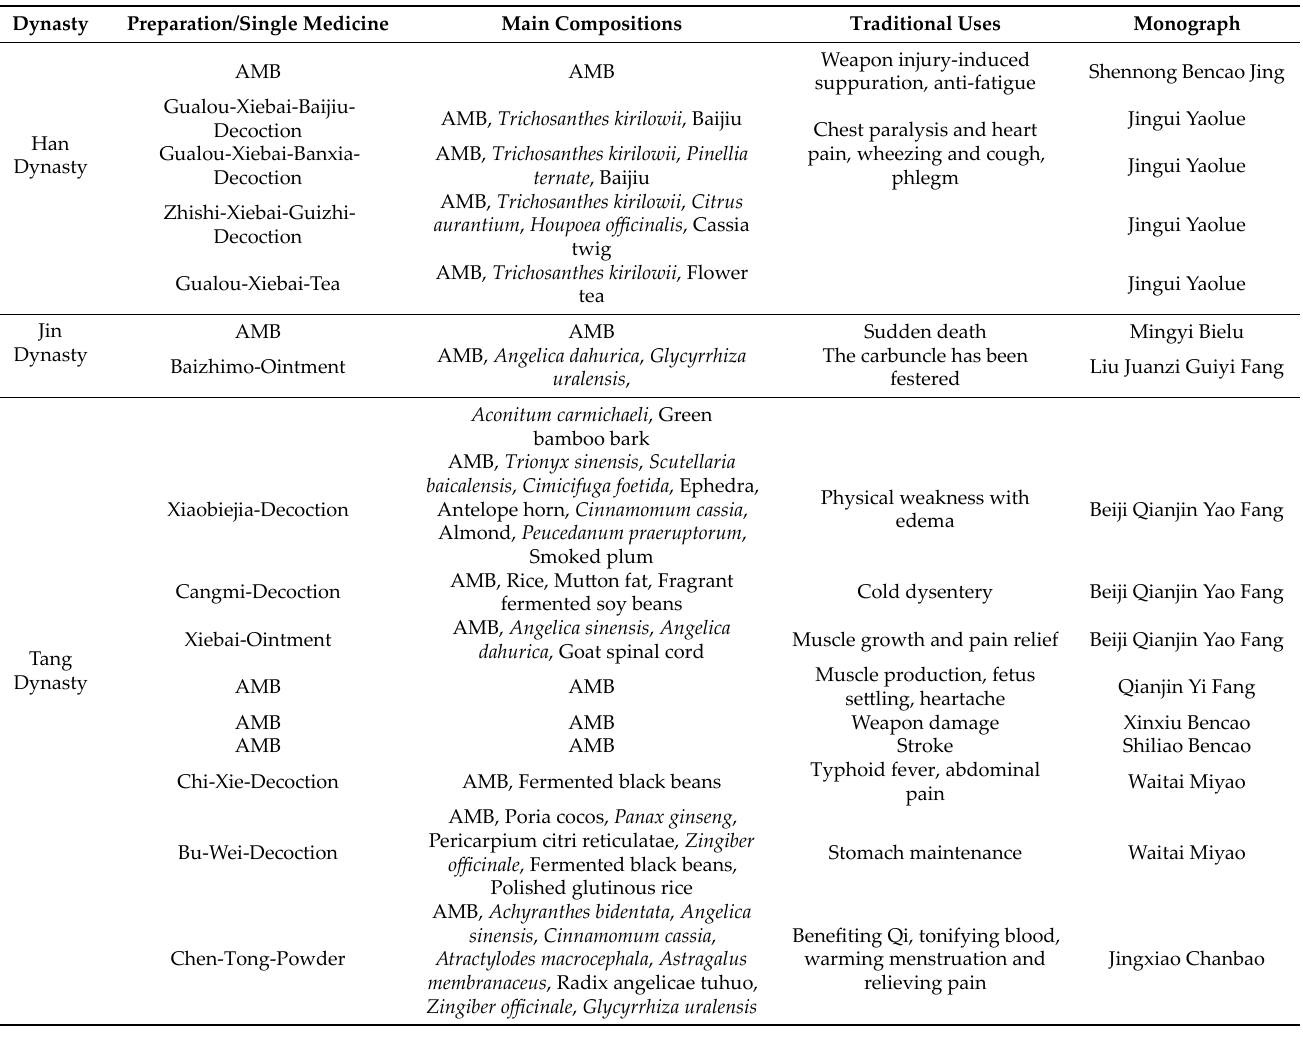
Table 3. Traditional uses of AMB in